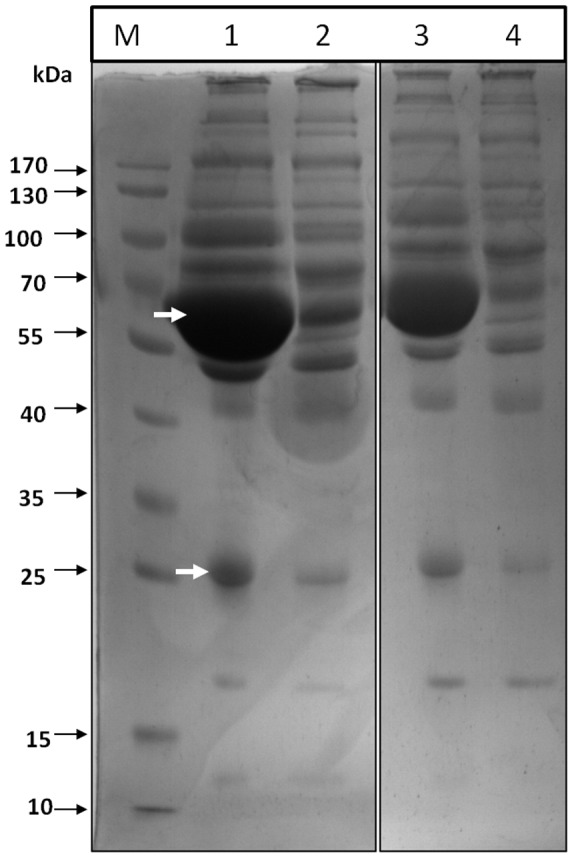
Representative SDS-PAGE image of depleted human plasma sample from control and high altitude native (HAN).Lane 1 and 3 represent crude plasma samples of control and HAN, respectively. Lane 2 and 4 represent depleted plasma samples of control and HAN, respectively. Lane M represents molecular weight marker.